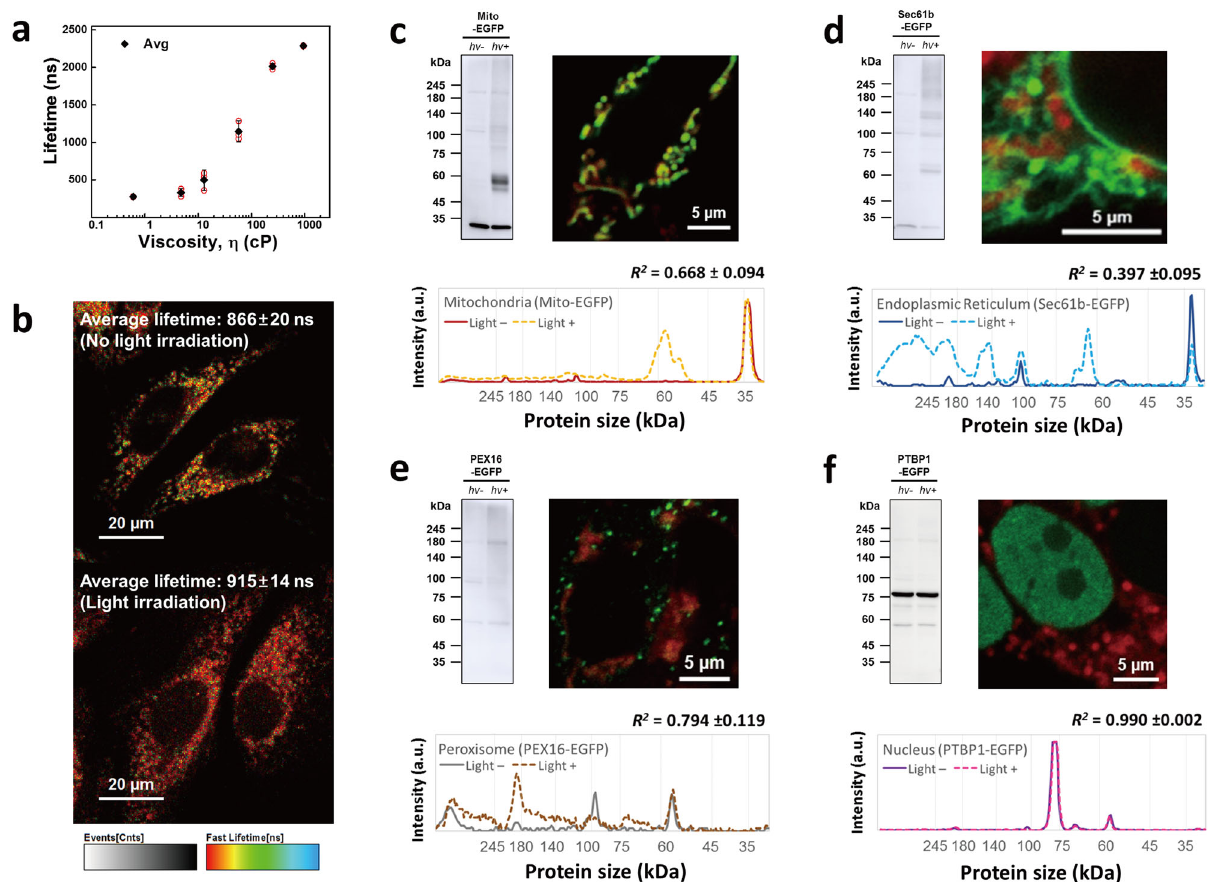
Fig. 4 Mitochondrial viscosity changes with photo-crosslinking using photoactivation of Ir-OA. a Viscosity-dependent change in the lifetime of Ir-OA. The in vitro viscosity was precisely controlled with glycerol content change in MeOH (v/v, %) from 0% to 95%. Data are presented as mean value ± s.d. ( n = 3). b Phosphorescence lifetime image (PLIM) of Ir-OA in mitochondria before and after photoirradiation. The described lifetime is averaged value of three images obtained under same condition ( n = 3). c – f Western blot (left) for identi fi cation of protein photo-crosslinking of Ir-OA depending on four different cell organelles: c mitochondria (Mito-EGFP); d ER (Sec61B-EGFP); e peroxisome (PEX16-EGFP); and f nucleus (PTBP1-EGFP). Co-localisation images (right) of Ir-OA (red signal) and each EGFP (green signal). λ ex = 405 nm and 488 nm (Ir-OA and EGFP, respectively). Pearson ’ s coef fi cient